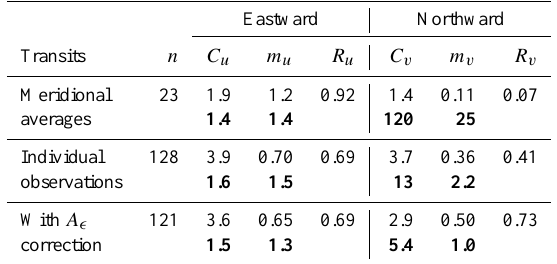
Table 2. Values of the constants C v , m v , C u , m u in the linear rela- tionships between the glider drift ( u G , v G ) and Aviso surface ( u A , v A ) , velocities u A = C u + m u u G (eastward) and v A = C v + m v v G (northward) along with the correlation coefficients, R u and R v , and the number of observations, n . The fits to Aviso data (standard font) and glider data (bold font) are shown. The best fit will be somewhere between the two. There is a marked improvement in the correlation of the individual northward currents once A (cid:15) is applied. Observa- tions were smoothed over about 1day with a four-point Hamming window and subsampled. The meridional averages are derived from the red and blue curves in Fig. 12b and